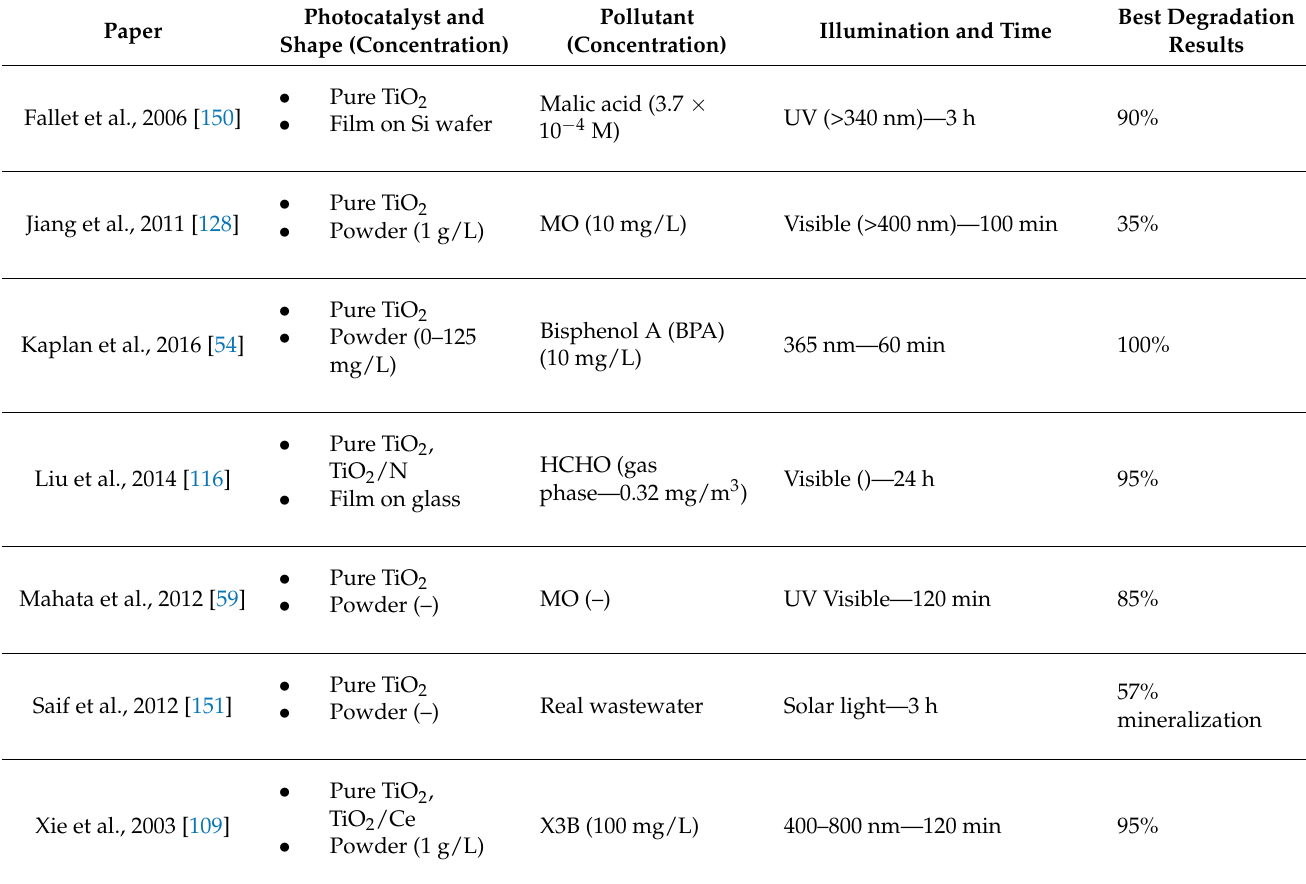
Table 4. Parameters of photocatalytic experiments for studies using aqueous TiO 2 materials after hydrothermal treatment.